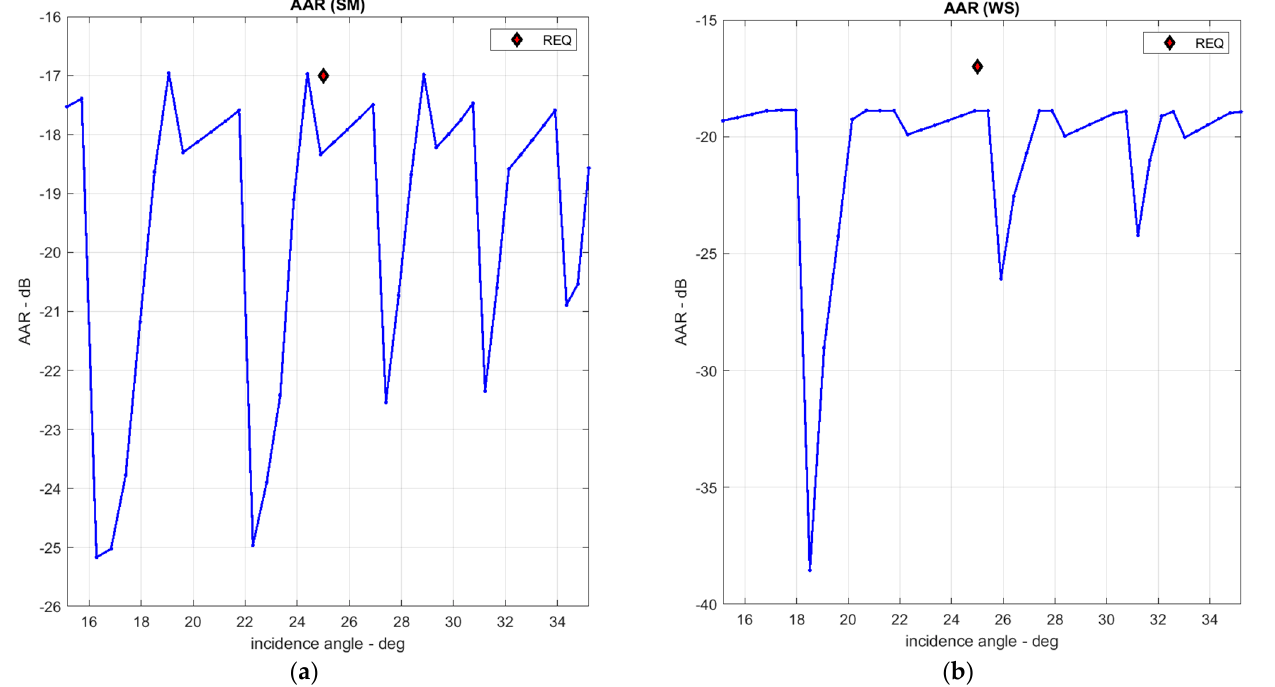
Figure 31. Azimuth ambiguity ratio vs. incidence angle of each antenna beam in ( a ) high-resolution and ( b ) wide-swath modes. AAR was lower than the required level of − 17 dB at an incidence angle of 25°.